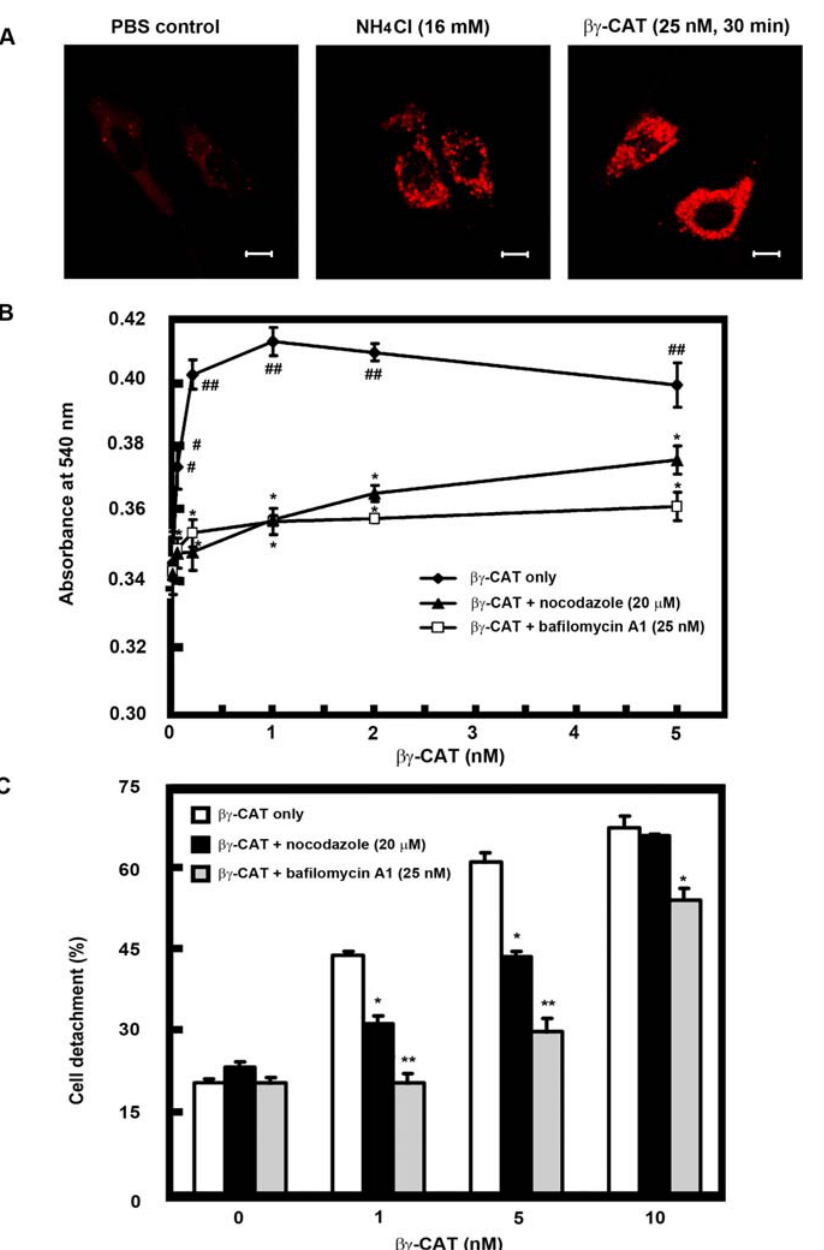
Figure 8. Vacuole formation of HUVECs induced by bc -CAT and inhibition by bafilomycin A1 and nocodazole. (A) Extensive cell vacuolation induced by high dosages of bc -CAT. HUVECs planted on glass coverslips were incubated with bc -CAT (25 nM) for 30 min. PBS-treated cells were used as a negative control and cells treated with NH 4 Cl (16 mM) for 18 h were used as a positive control. The cells were stained with neutral red as described in ‘‘Methods’’. The vacuole formation in the cells was observed by confocal microscope. Scale bars equal to 10 m m. (B) Neutral red uptake of bc -CAT treated HUVECs in the absence and presence of bafilomycin A1 and nocodazole. HUVECs (2.5 6 10 4 cells/ml) seeded in 96 well titer plates were incubated with bafilomycin A1 (25 nM) or nocodazole (20 m M) for 30 min at 37 u C, then different concentrations of bc -CAT (50 p M-5 nM) were added and incubated for another 30 min. Neutral red uptake was performed as described in ‘‘Methods’’. (C) Inhibition of cell detachment induced by bc -CAT in the presence of bafilomycin A1 and nocodazole. HUVECs planted in 24-well plates were incubated with bafilomycin A1 (25 nM) or nocodazole (20 m M) for 30 min at 37 u C, then bc -CAT (1 nM, 5 nM and 10 nM) was added and incubated for 5 h. Cell detachment was analyzed as described in ‘‘Methods’’. Data were expressed as means 6 SEM of triplicate measurements ( # , p , 0.05; ## , p , 0.01, compared with zero bc -CAT (B); *, p , 0.05; **, p , 0.01, compared with the bc -CAT only group (B–C).